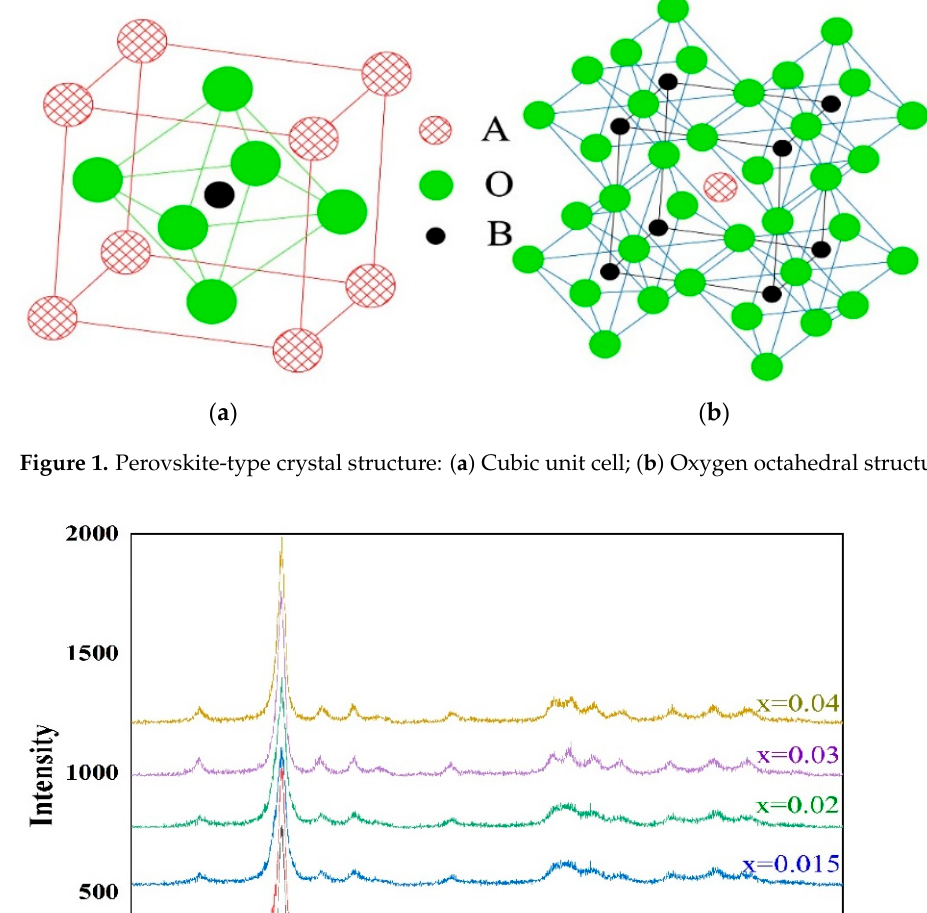
Figure 1. Perovskite ‐ type crystal structure: ( a ) Cubic unit cell; ( b ) Oxygen octahedral structure.